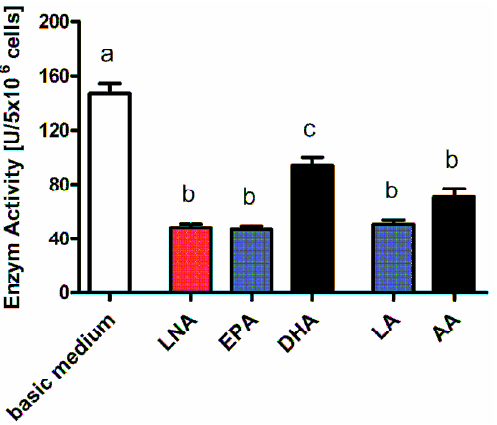
Figure 11. Total enzyme activity of lysozyme of RAW264.7 macrophages cultured in basic medium as well as in medium supplemented with 15 µmol/L alpha-linolenic acid (LNA), eicosapentaenoic acid (EPA), docosahexaenoic acid (DHA), linoleic acid (LA) or arachidonic acid (AA). Data are mean ± SD ( n = 6). Bars denoted by different letters are significantly